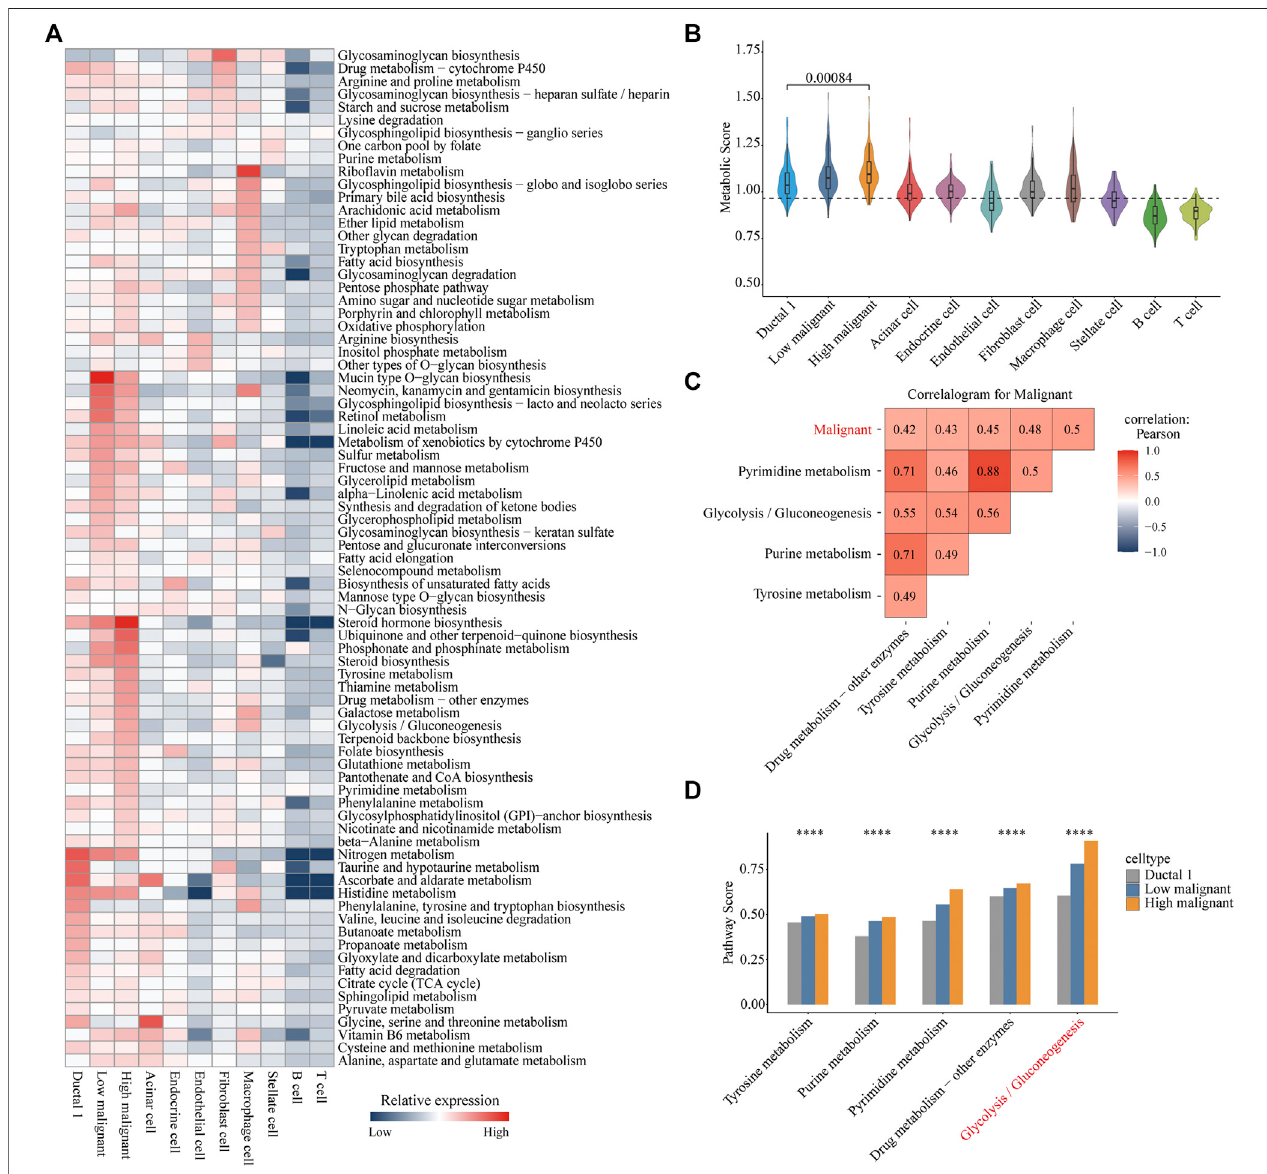
FIGURE2| Metabolic reprogrammingin highlymalignantcellsubpopulations. (A) Heatmap ofexpression demonstratingthe abundance ofKyoto Encyclopediaof Genes and Genomes (KEGG) metabolic pathways in different cell types in pancreatic ductal adenocarcinoma. (B) Violin plots for metabolic score of each cell type. Wilcoxonranktest, p =0.00084. (C) Correlationheatmap(Pearsoncorrelation)ofthemetabolicpathways(top fi ve) withthehighestcorrelation tomalignant scoresinall carcinoma cells. Red, positive correlation; blue, negative correlation; white, no correlation. (D) Bar chart is shown with the pathway scores of fi ve metabolic pathways in three cell types, and p -values were calculated using ANOVA analysis. Ductal 1 cell, gray bar chart; lowly malignant, blue bar chart; highly malignant, orange bar chart. **** p < 0.0001.